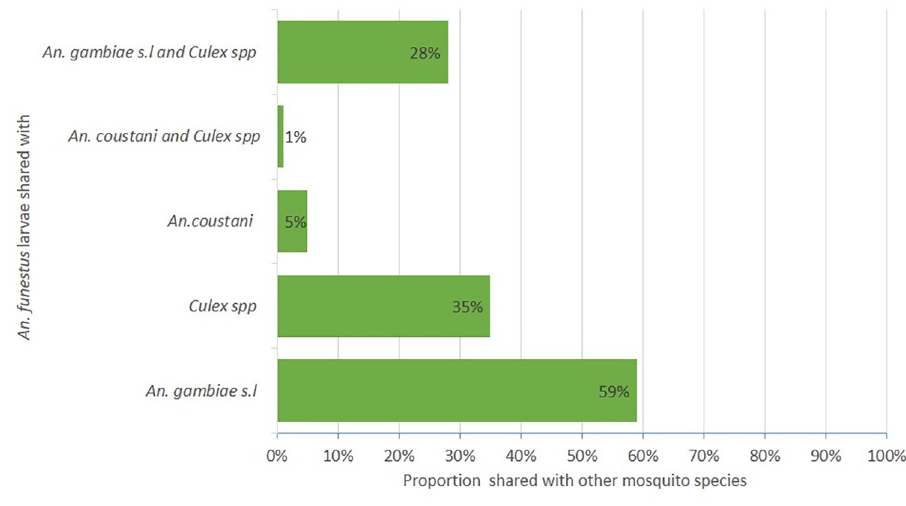
Fig 2. Proportion of An . funestus larvae shared with other mosquitoes in the larval habitats.